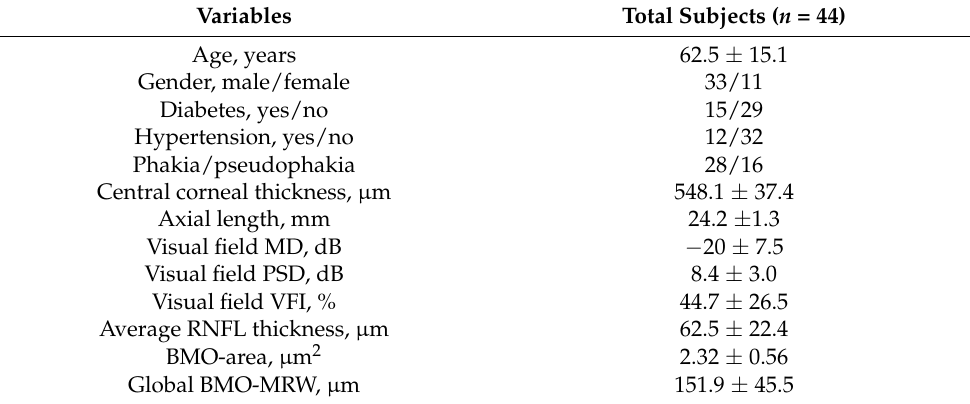
Table 1. Demographic and baseline characteristics of the